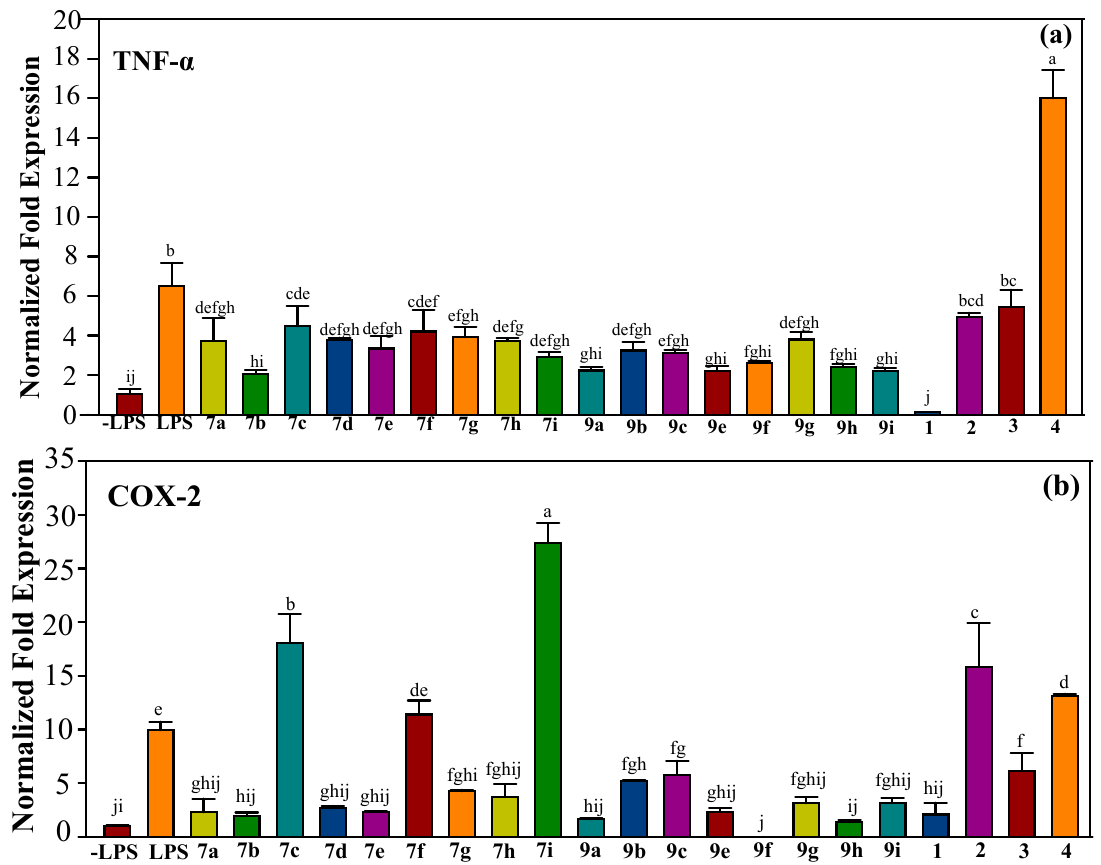
Figure 8. mRNA expression of ( a ) TNF- α and ( b ) COX-2. RAW 264.7 cells were pre-treated with synthetic or natural compounds (10 μ g/mL) for 1 h before induction of inflammation by LPS (1 μ g/mL) for 6 h. Values indicate means ± SD. Bars with the same letters are not significantly different ( α = 0.05). LPS: lipopolysaccharide; 7a – i are synthetic halo-substituted chalcones; 9a – i are synthetic halo-substituted azachalcones; 1 – 4 are synthetic natural products.